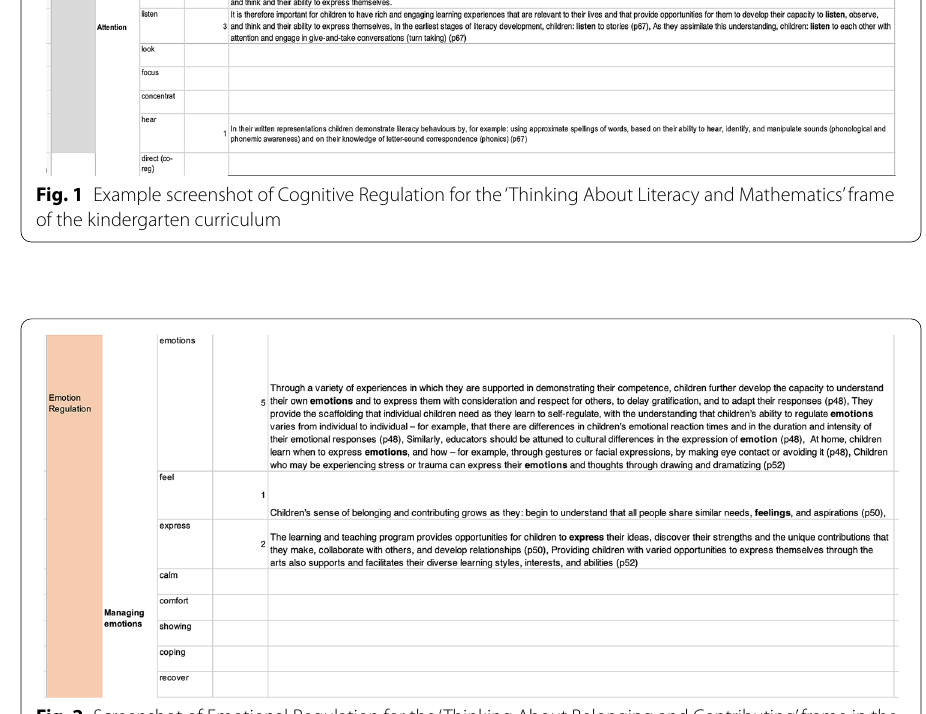
Fig. 2 Screenshot of Emotional Regulation for the ‘Thinking About Belonging and Contributing’ frame in the kindergarten